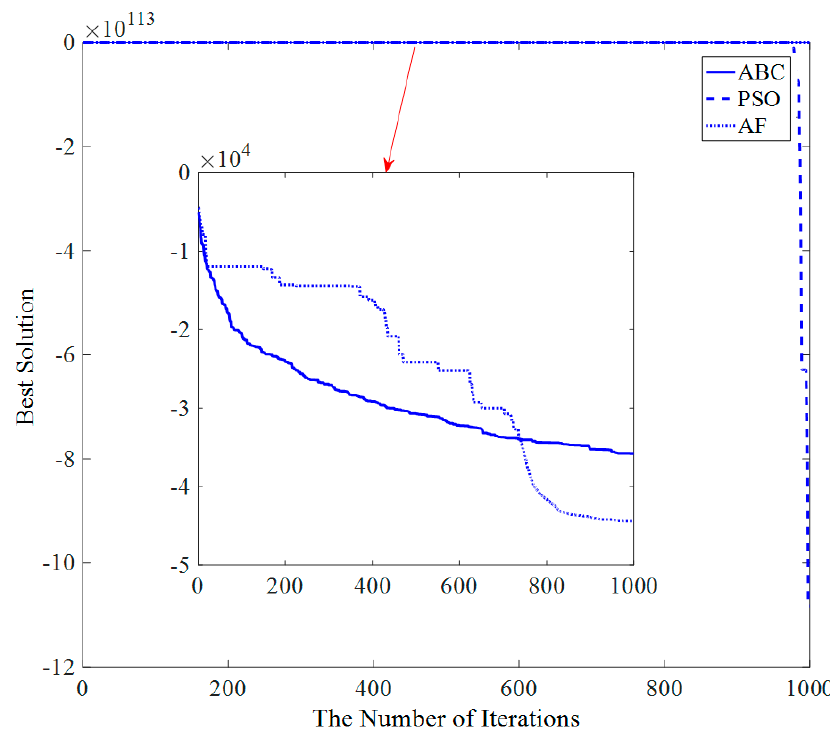
Appl. Sci. 2018 , 8 , x FOR PEER REVIEW Figure 18. The convergence curve of the three algorithms for Schwefel function in 100-dimensional space.